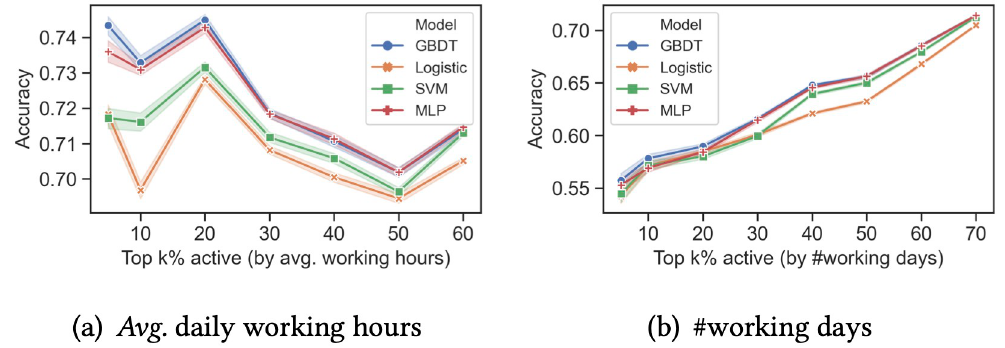
Fig 3. Accuracy of dropout predictions for emoji users is above 0.7 when including all activity levels and as high as 0.75 for those who work longer hours per working day. Baseline is 0.5 for all activity levels and is omitted. (a): Avg . daily working hours. (b): #working